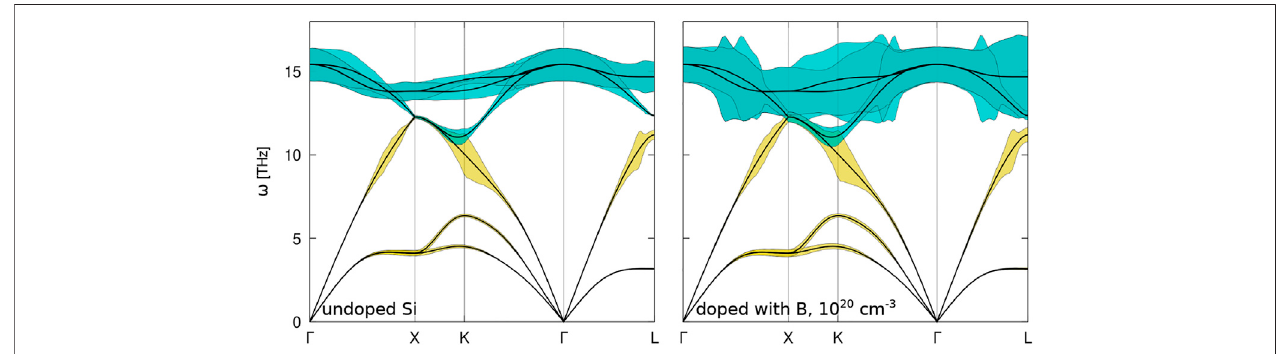
FIGURE9| PhonondispersionofSiundoped (left) anddopedwithB (right) .Thelinewidth(inverserelaxationtime)ofacousticandopticalmodesisrepresentedin yellow and cyan, respectively. For better visual presentation, the value of the linewidth has been multiplied by 20.